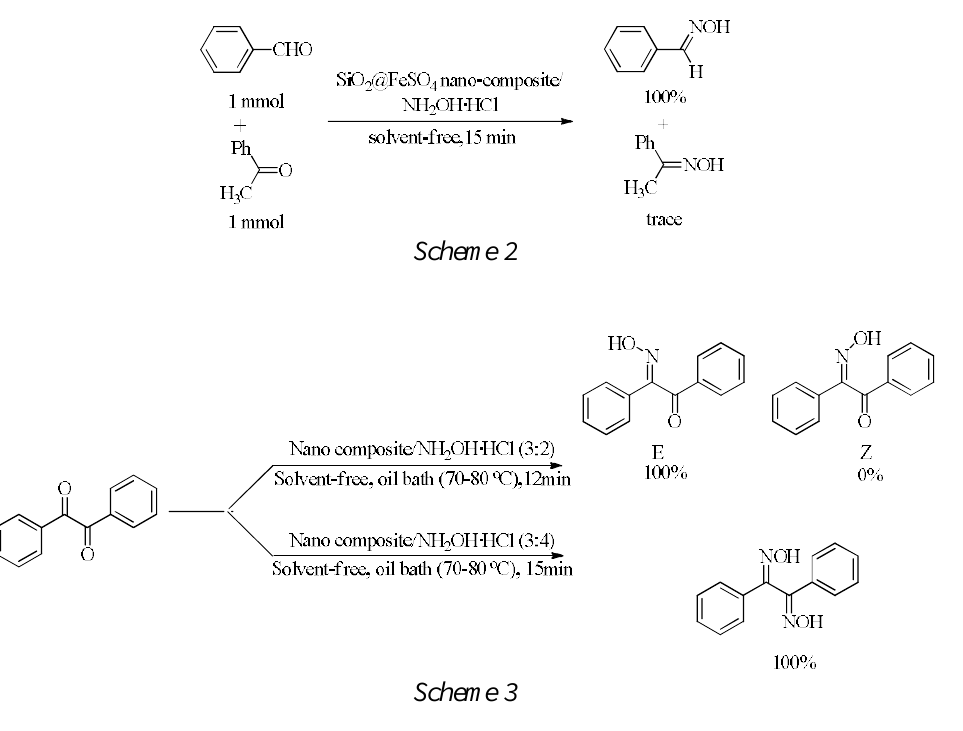
Table 4. Comparison of Conversion of Carbonyl Compounds to Oximes with SiO